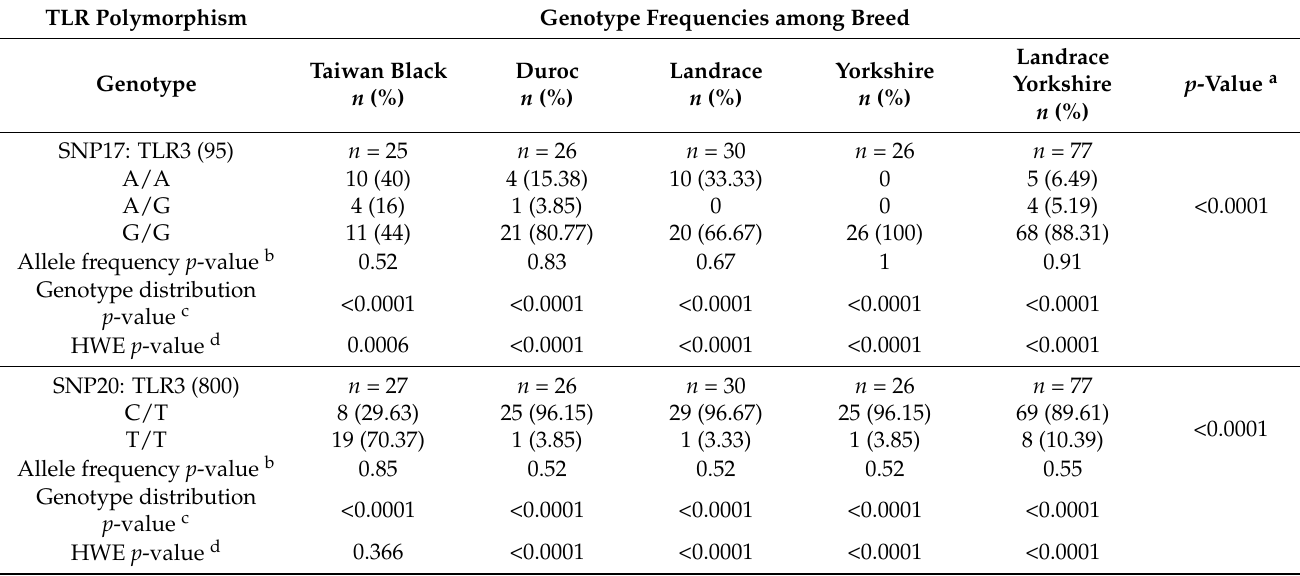
Table 6. The genotype distribution of SNPs in TLR genes and their association with different pig breeds. TLR